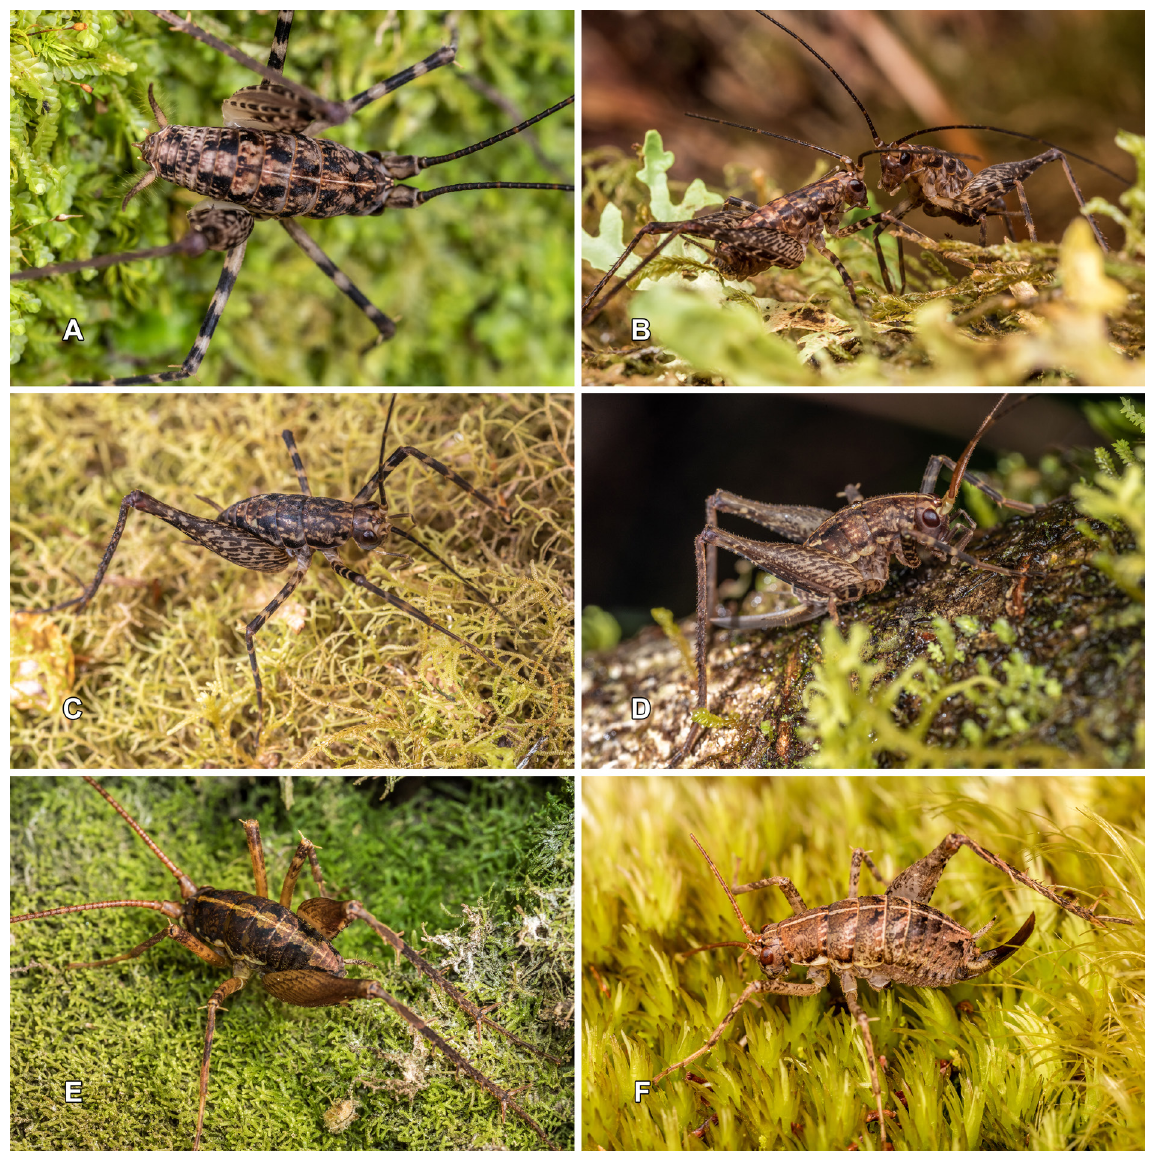
Fig. 15. Live Pleioplectron Hutton, 1896 in their natural environments. A . P. auratum sp. nov., adult ♂, Whites Beach, Rarangi. B . P. gubernator sp. nov., two adult ♂♂, Three Pointer, Gouland